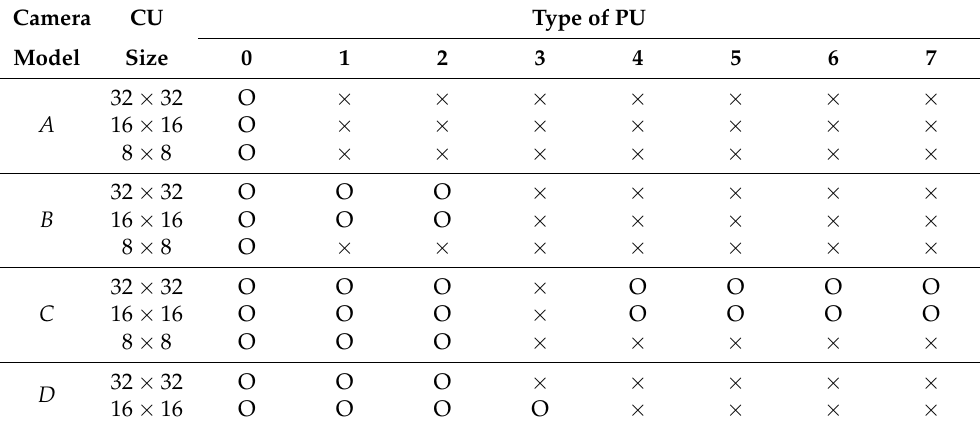
Table 12. Example of block partitioning of inter coded CU in HEVC encoder’s descriptors. Here, inter predict modes 0, 1, 2, 3, 4, 5, 6, and 7 correspond to 2 N × 2 N , N × N , 2 N × N , N × 2 N , 2 N × nU , 2 N × nD , nL × 2 N , and uR × 2 N PUs, respectively. Here, O and × represent ‘used’ and ‘not used’, respectively. Type of